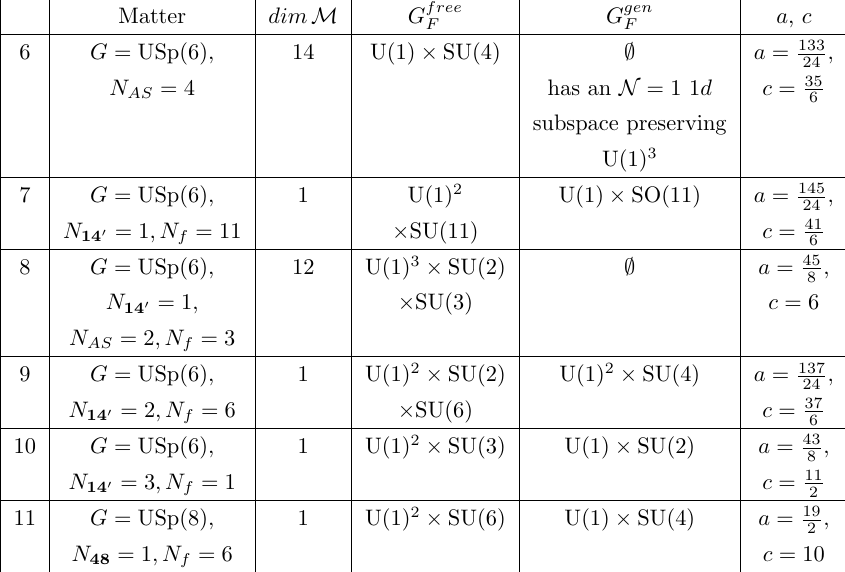
Table 29 . Cases involving a USp(2 N ) gauge group with extended supersymmetry, continued. (cid:15) In case 3 the N = 2 preserving 1 d subspace also preserves a U(1) (cid:2) SU(2) 2 (cid:2) USp(4) global symmetry, where one breaks SU(4) ! SO(4), and the SU(2) 2 is the SO(4). F In addition, one breaks SU(4) ! USp(4). One can further continue and break AS the SO(4) to its Cartan, and U(1) (cid:2) USp(4) ! U(1) (cid:2) SU(2) 2 ! U(1) (cid:2)